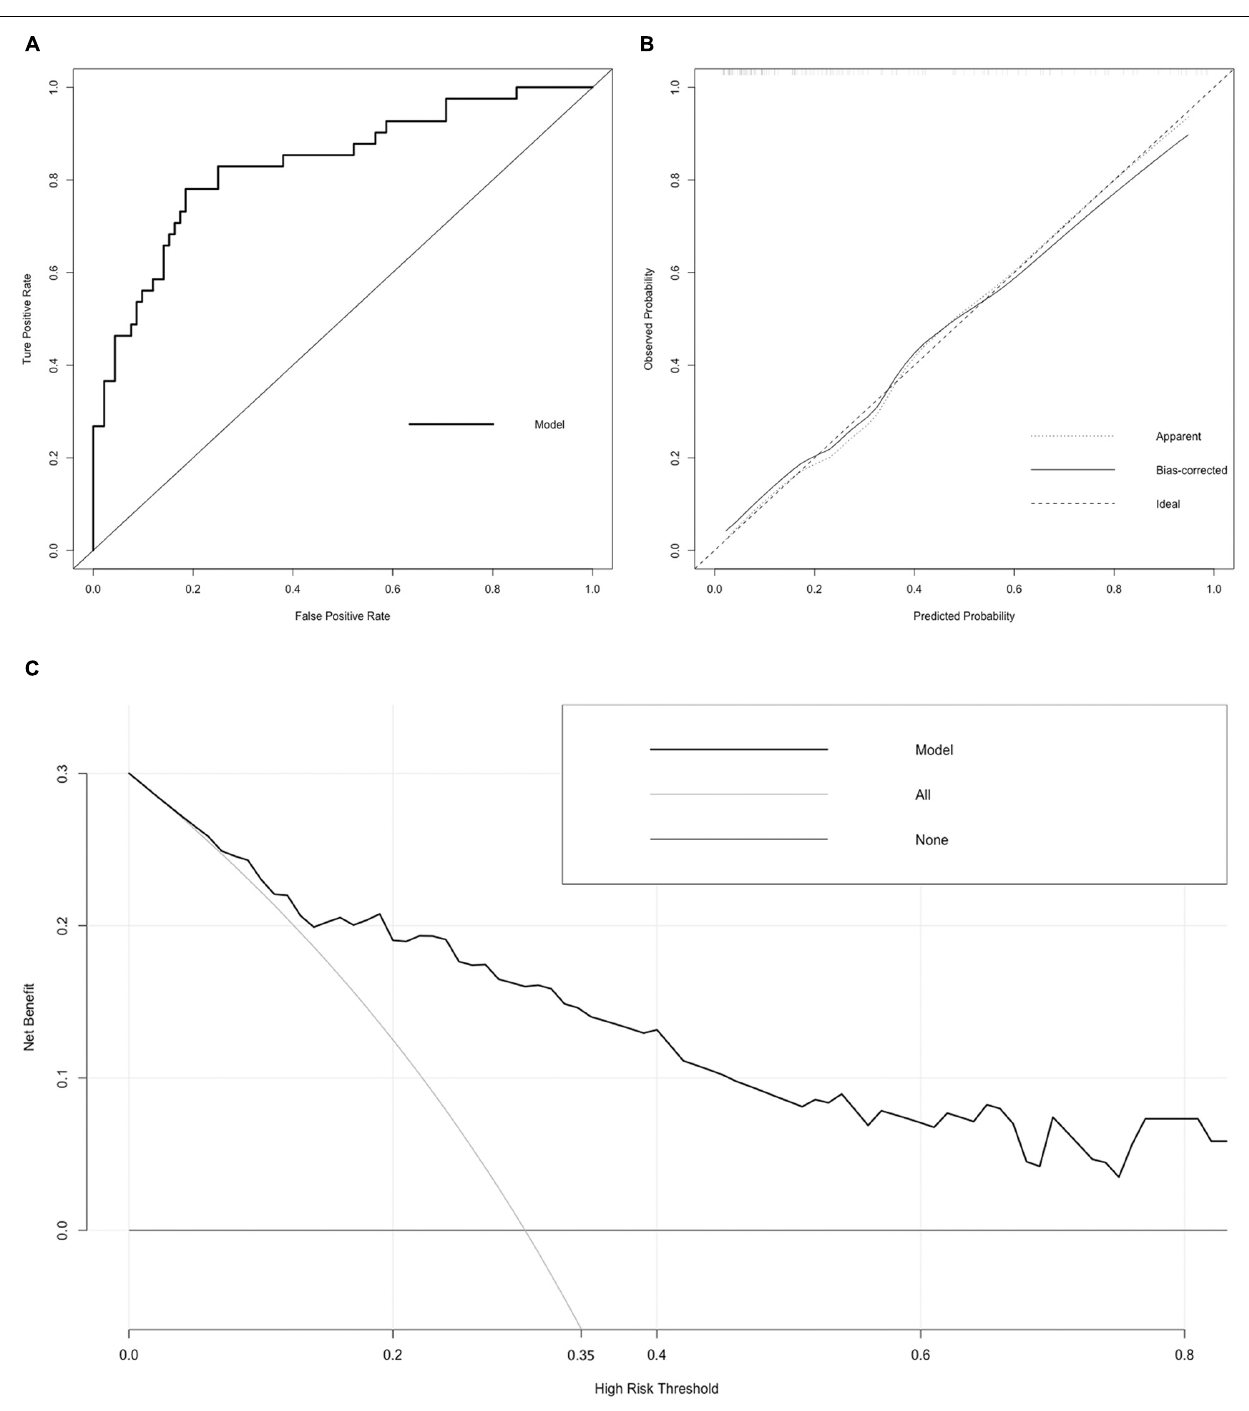
Frontiers in Pediatrics |